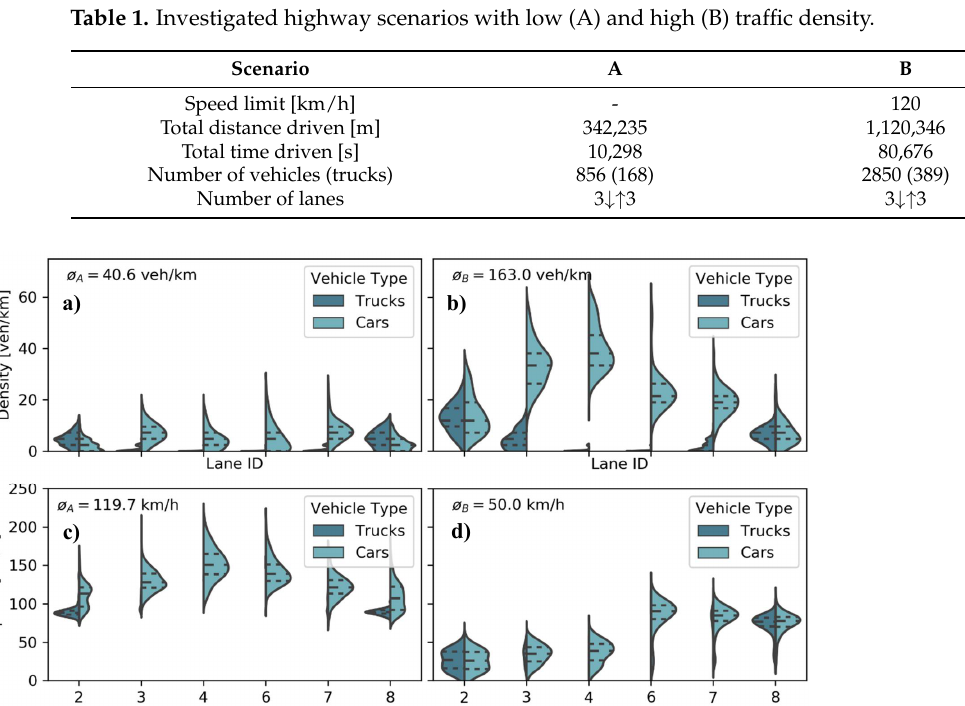
Figure 5. Traffic characterization in terms of: ( a+b ) vehicle density and ( c+d ) speed distribution for ( a+c ) the low and ( b+d ) the high traffic density scenario with their respective quartiles (dotted lines). Traffic speed and density have a high impact on the performance of collective perception.